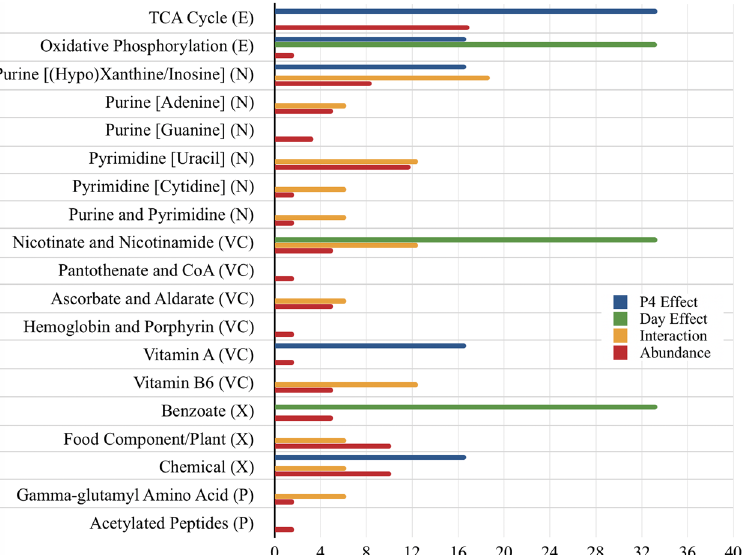
Figure 3. The contribution (%) of each sub-pathway to total ( a ) progesterone (P4) effects – i.e . the proportion of corresponding metabolites which were hormonally responsive, ( b ) day effects – i.e . the proportion of corresponding metabolites which were temporally dynamic, ( c ) day by P4 interactions – i.e . the proportion of corresponding metabolites whose concentrations differed between groups (normal vs . high P4) at different times (Days 12 vs . 13 vs . 14), and ( d ) abundance – i.e . the size of the sub-pathway. Abbreviations: progesterone (P4), super-pathways: energy metabolite (E), nucleotide metabolite (N), vitamin and cofactor metabolite (VC), xenobiotic (X), and peptide (P).